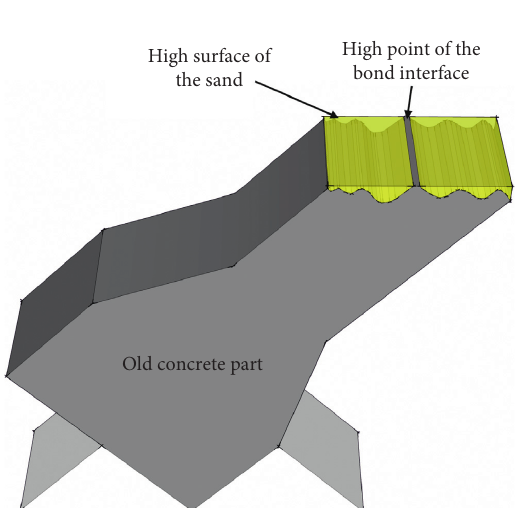
Figure 2: Specimen preparation.